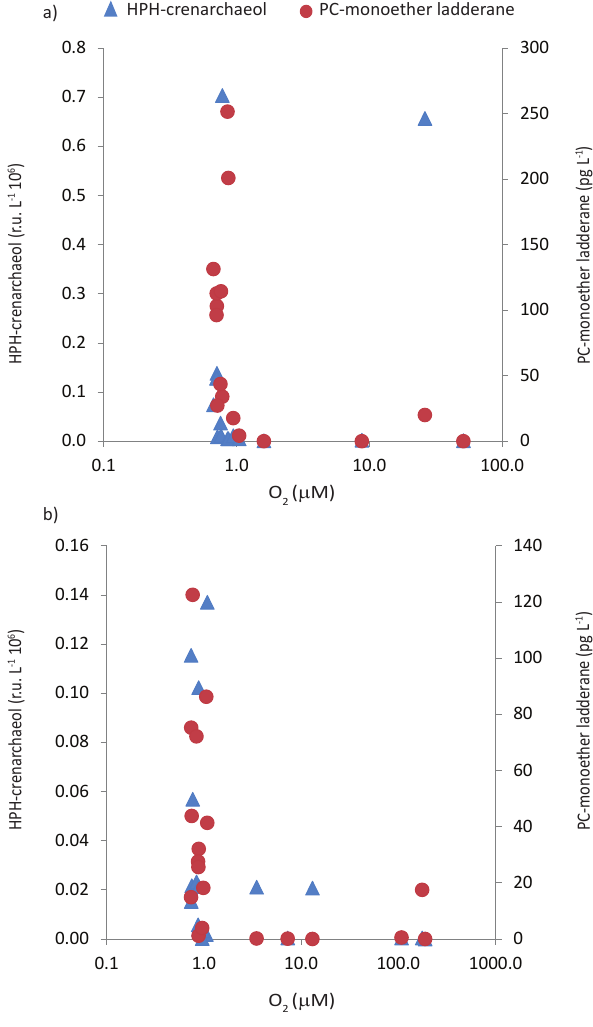
Figure 4. Abundance of HPH-crenarchaeol (r.u.L − 1 , i.e., response units per liter) and PC-monoether ladderane lipids (pg L − 1 ) accord- ing to the concentration of oxygen (µM). The upper panel (a) shows the response of the two biomarkers at the coastal site, while the lower panel shows (b) the response at the open-ocean